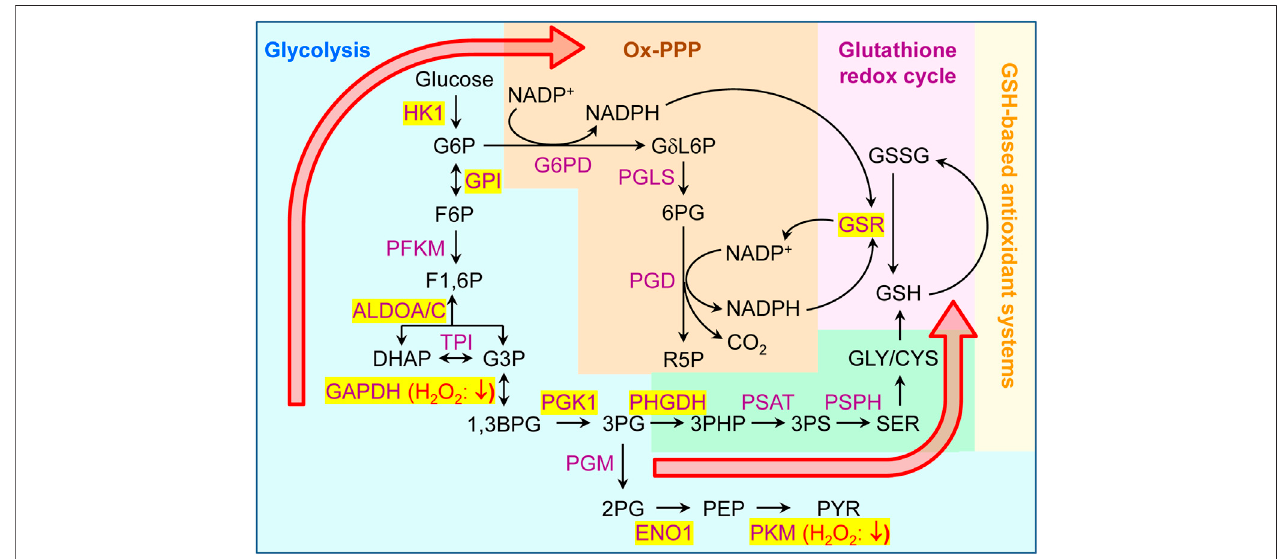
FIGURE 12 | Peroxisome-derived H 2 O 2 can oxidatively modify multiple glycolytic enzymes. Schematic outlining a simpli fi ed overview of glycolysis, the oxidative branch of the pentose phosphate pathway (Ox-PPP), and the glutathione redox cycle. Metabolic enzymes and metabolites are indicated in purple and black, respectively. Enzymes that become sulfenylated upon peroxisomal H 2 O 2 production are shown on a yellow background. Based on evidence found in the literature (Mullarky and Cantley, 2015), oxidation of GAPDH and PKM respectively (i) redirects the glycolytic fl ux towards ox-PPP (through an increase in the metabolites upstream of GAPDH), and (ii) increases the synthesis of the glutathione precursors glycine and cysteine (through activation of serine synthesis by a buildup of 2PG). 1,3BPG, 1,3-bisphosphoglycerate; 2PG, 2-phosphoglycerate; 3PG, 3-phosphoglycerate; 3PHP, 3-phosphohydroxypyruvate; ALDO, aldolase, CYS, cysteine; DHAP, dihydroxyacetone phosphate; ENO, enolase; F1,6P, fructose-1,6-bisphosphate; F6P, fructose-6-phosphate; G3P, glyceraldehyde-3-phosphate; G6P, ribulose 5- phosphate; GAPDH, glyceraldehyde-3-phosphate dehydrogenase; GLY, glycine; GPI, glucose-6-phosphate isomerase; GSR, glutathione-disul fi de reductase; GSH, glutathione (reduced); GSSG, glutathione (oxidized); HK, hexokinase; NADP+, nicotinamide adenine dinucleotide phosphate (oxidized); NADPH, nicotinamide adenine dinucleotide phosphate (reduced); PFKM, phosphofructokinase, muscle; G6PD, glucose-6-phosphate dehydrogenase; G δ L6P, 6-phospho-D-glucono-1,5-lactone; PEP, phosphoenolpyruvate; PGD, 6-phosphogluconate; PGK, phosphoglycerate kinase; PGM, phosphoglucomutase; PHGDH, phosphoglycerate dehydrogenase; PKM, pyruvate kinase; PS, phosphoserine; PSAT, phosphoserine aminotransferase; PSPH, phosphoserine phosphatase; PYR, pyruvate; SER,